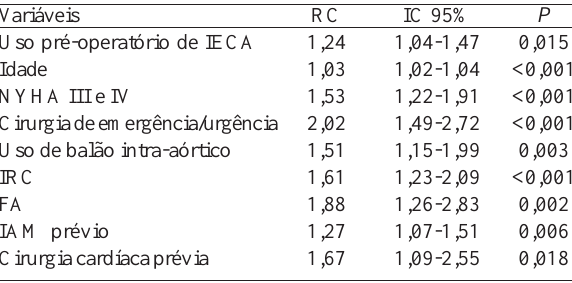
Tabela 2. Análise multivariada de preditores de suporte inotrópico